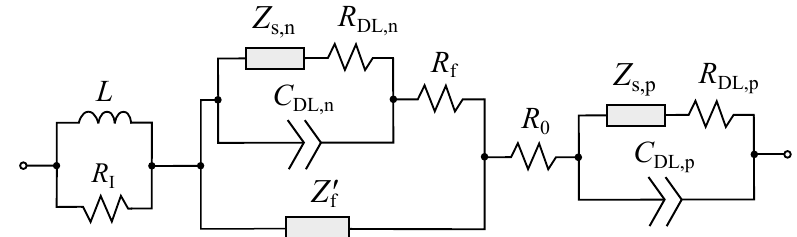
Figure 6. The LIB equivalent circuit model obtained on the basis of the subdiffusion generalization of the electrochemical SP